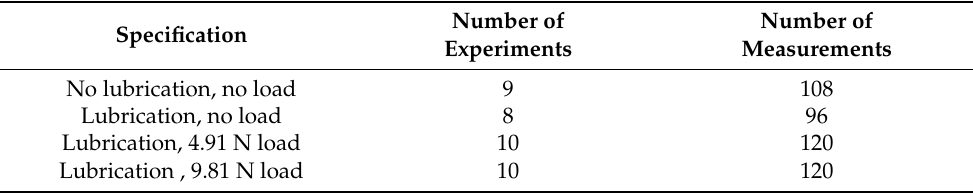
Table 2. Breakdown of experiments and measurements.